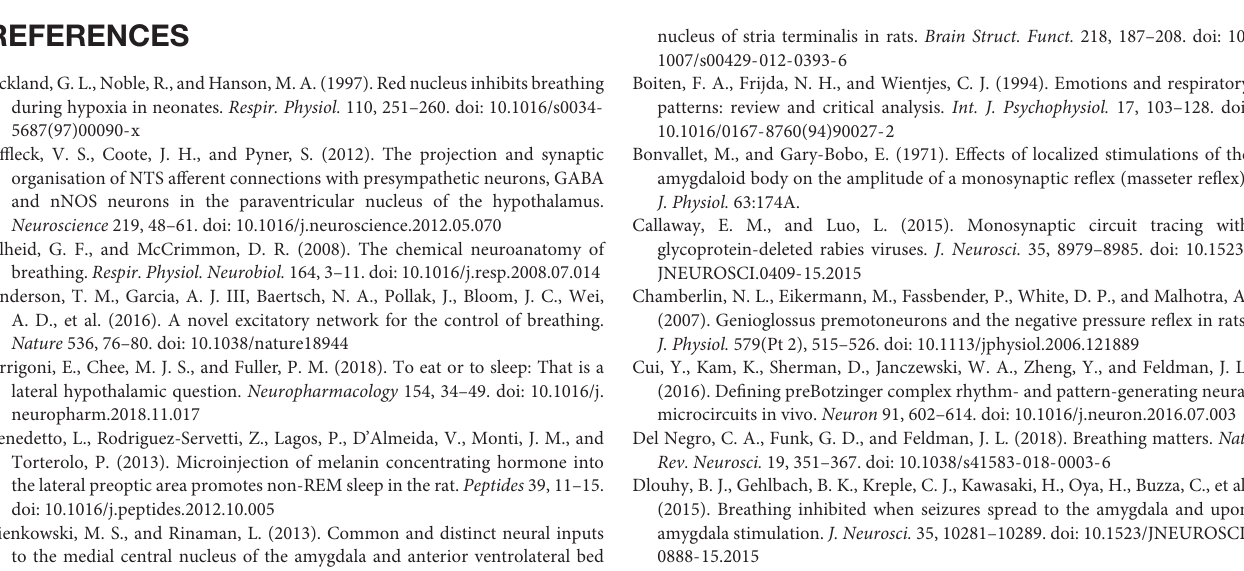
FIGURE S1 | Retrograde labeling of putative afferent projections to the preBötC. Fluorogold injections into the preBötC [ (A) , arrow] result in retrograde labeling of neurons throughout the brain including the nucleus of the solitary tract (NTS) contralateral preBötC, parafacial and facial (VIIn) nuclei, parabrachial nuclei and Kölliker-Fuse (PB/KF), trigeminal nucleus (MO5), substantia nigra, red nucleus, superior colliculus, central amygdala, lateral hypothalamus, and zona incerta, paraventricular hypothalamus, bed nucleus of the stria terminalis (BNST), lateral preoptic area (LPO), and cortex (B–P) . (ChAT staining, red), (scp,